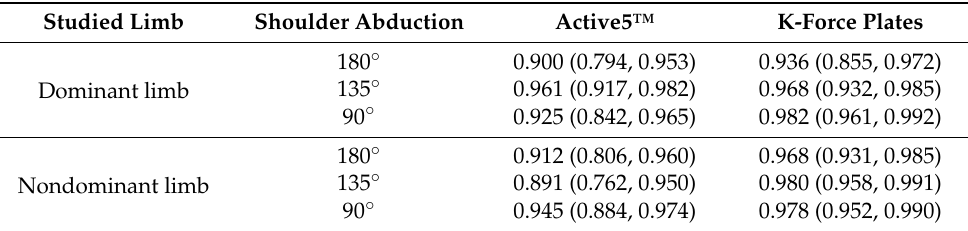
Table 9. Intrarater reliability of the ASH test using both studied devices in the male